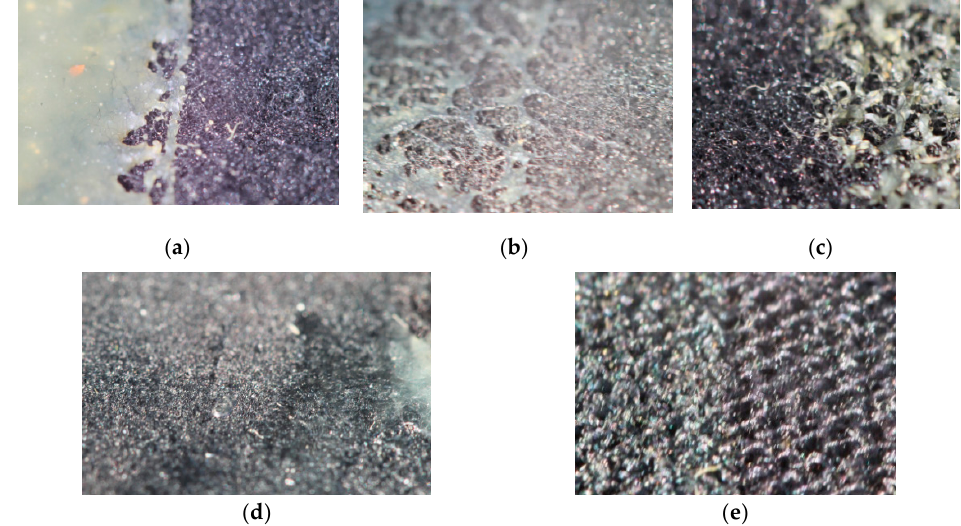
Figure 7. Experimental result of the influence of temperature of ( a ) 80, ( b ) 90, ( c ) 100, ( d ) 120 and ( e ) 150 °C on the formation of a polymer coating on the fabric surface.